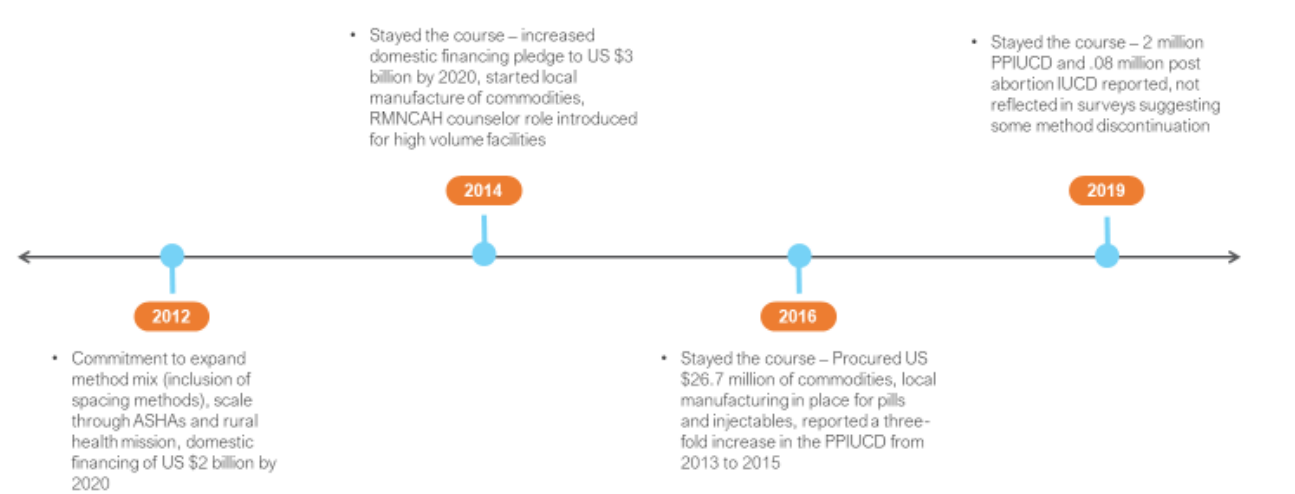
Figure 3. India FP2020 commitments and timeline. ASHAs – Accredited Social Health Activist; RMNCAH – reproductive, maternal, newborn, child and adolescent health; PPIUCD – post-partum intra-uterine contraceptive device; IUCD - intra-uterine contraceptive